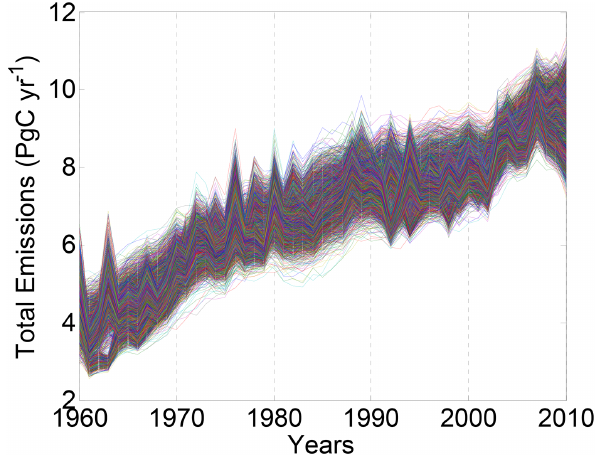
Figure 5. Total emission scenarios including uncertainty. Plotted are all combinations of the sum of land use and fossil fuel emission estimates included in this study A total of 500 realizations for each of the three land use emission estimates and each of the fossil fuel emission estimates is included for a total of 4500 global emission realizations (each colored line).